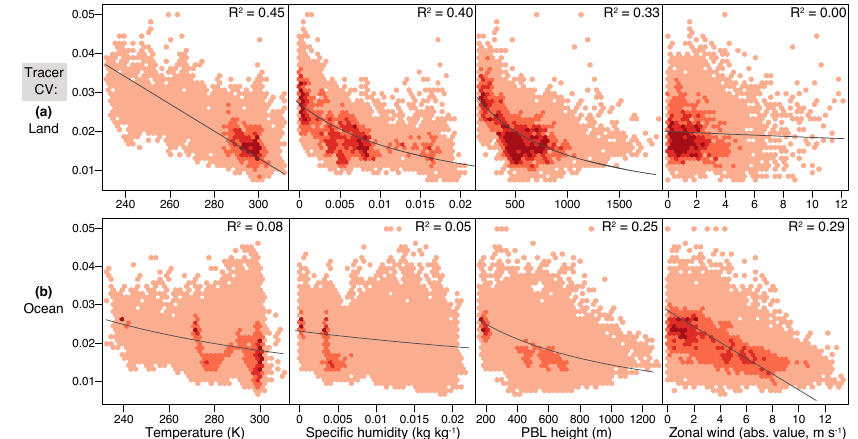
Figure 7. Each panel shows the relationship between the synthetic tracer CV (Fig. 6) and various monthly-averaged meteorological param- eters estimated by CAM-LETKF. The top row ( a ) shows the results for terrestrial regions while the bottom row ( b ) displays the results for ocean/marine regions. Darker colors in each panel indicate a higher density of points. We test the correlation with 60 different parameters (Table S2 in the Supplement) and plot the two parameters that correlate most closely with the tracer CV over terrestrial and marine regions, respectively. In all cases, we fit both a standard major axis regression and nonlinear least squares ( 1 [ with the higher correlation